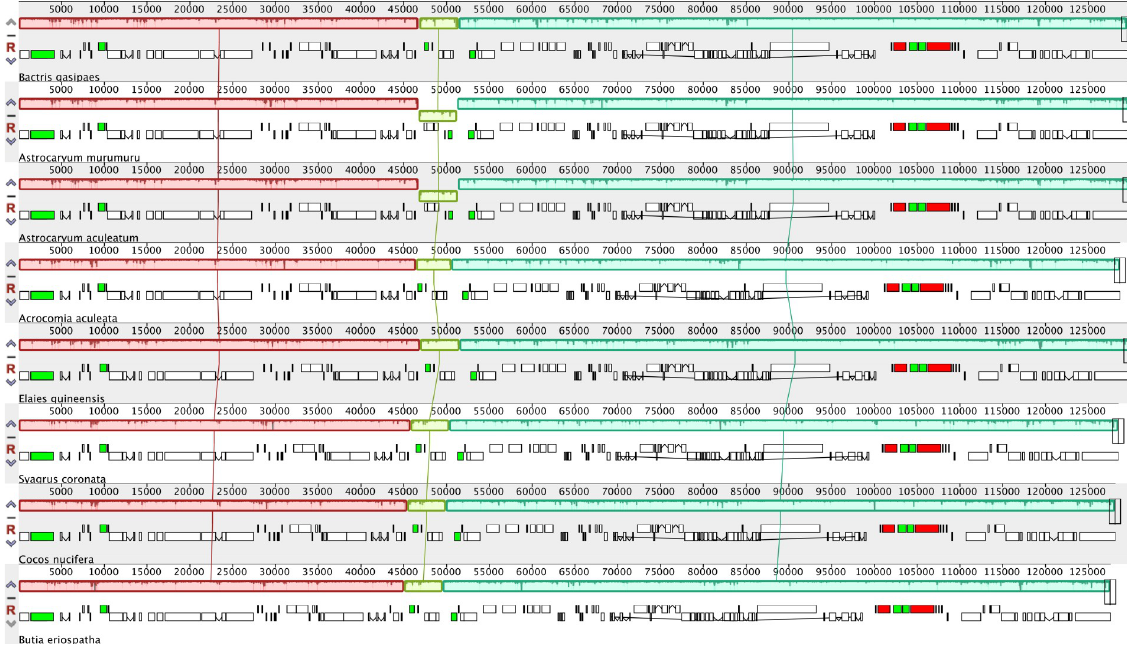
Fig 1. Plastome rearrangement analysis within tribe Cocoseae. Locally collinear blocks (LCBs) are identified by colors. The 4.5 kb inversion in Astrocaryum is in green.